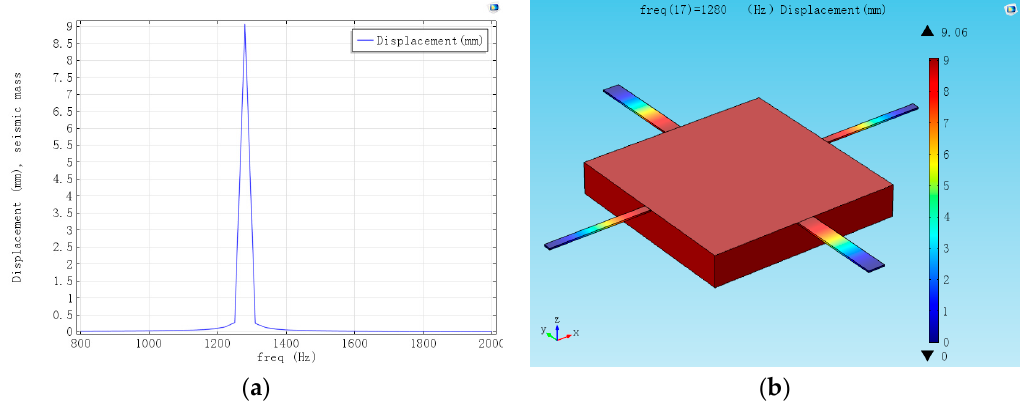
Figure 9. Frequency domain and displacement of the structure in natural frequency. ( a ) Frequency domain; ( b ) Displacement of the structure in natural frequency.